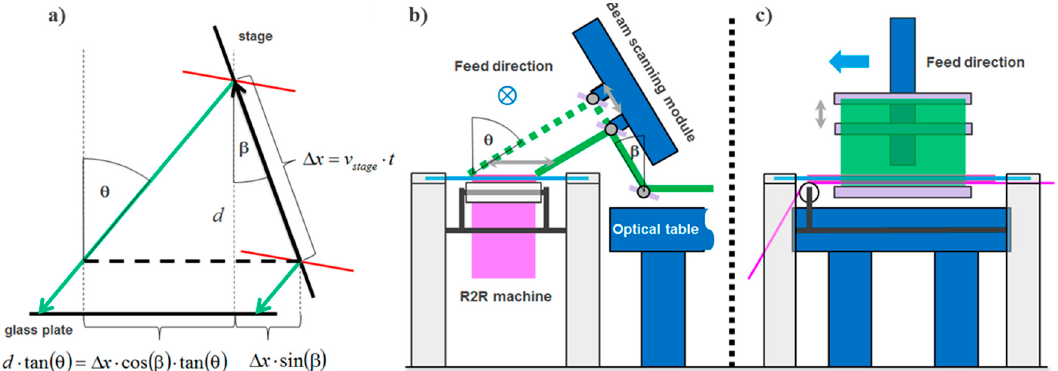
Figure 25. Detailed layout of the laser scanning module. ( a ) Geometrical model; ( b,c ) sketch of module. The incidence angle θ can be varied between 20° and 60°, whereas the slanted mount of the stage β is fixed to 20°